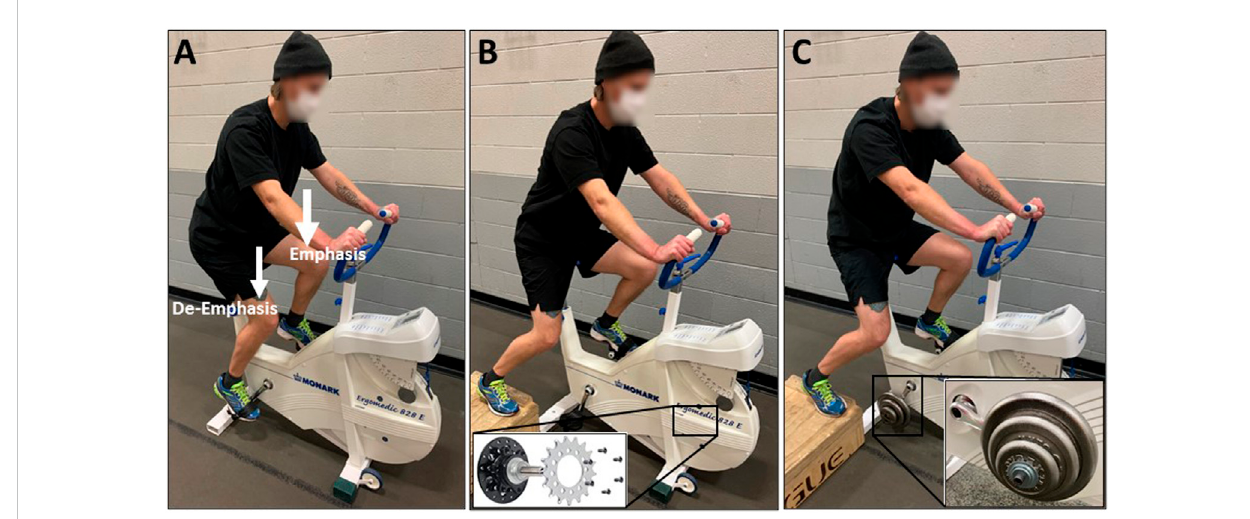
FIGURE 2 The various methods for facilitating single-leg cycling. (A) Single-leg emphasis: Using a standard cycle ergometer or bicycle, the individual cycles with both legs while instructed to focus on only one leg by “ pushing down ” during the limb extension phase. The contralateral leg is simply “ along for the ride ” and its weight helps during the fl exion phase of the emphasized leg. (B) Fixed gear: The cycle ergometer is adapted by removing the freewheel mechanism from the drivetrain cog and af fi xing it directly to the fl ywheel. This allows the individual to cycle with one leg while utilizing the fl ywheel inertia to aid during the limb fl exion phase. (C) Counterweight: The cycle ergometer is adapted by attaching a specialized pedal spindle with weights (~10 kg) mounted to the contralateral crank arm. This allows the individual to cycle with one leg while utilizing the inertia of the counterweight to aid during the limb fl exion